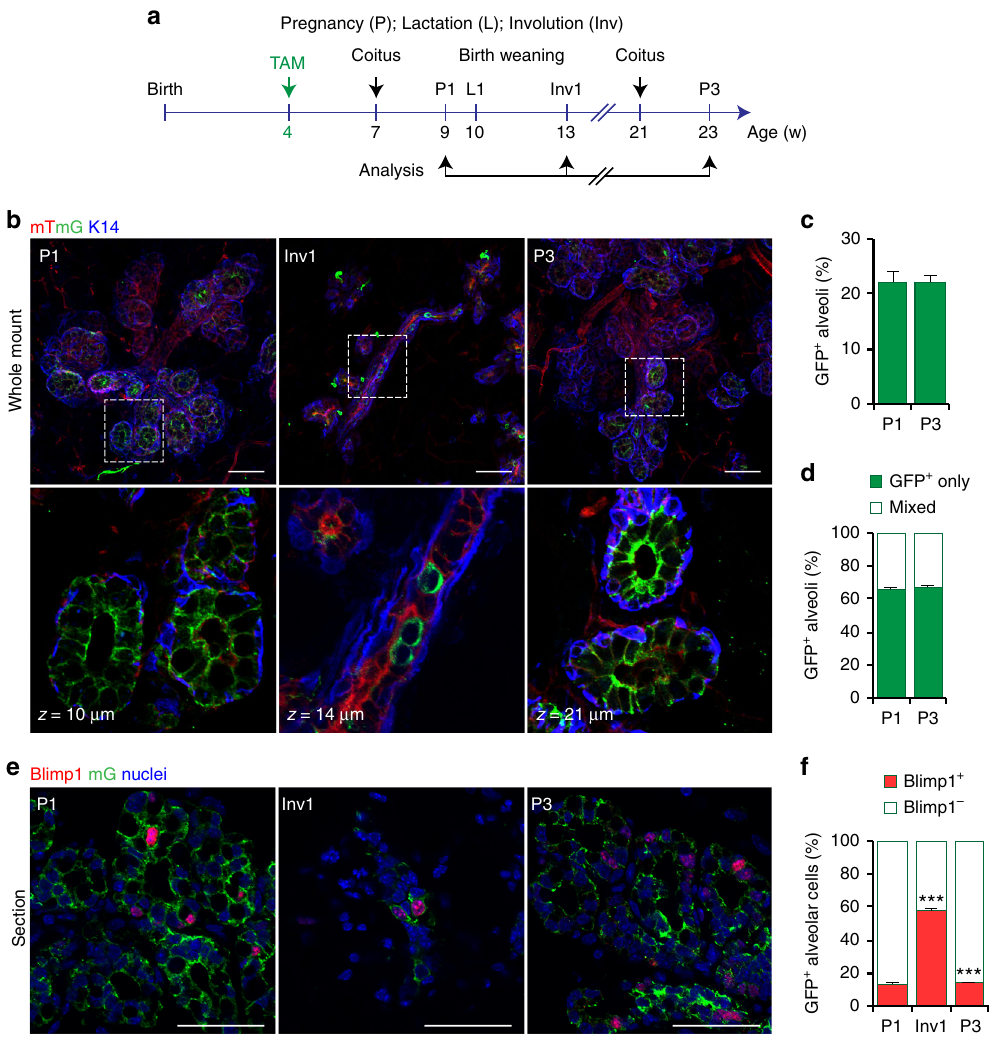
Fig. 4 Blimp1-derived cells represent long-lived luminal stem cells that contribute actively to consecutive pregnancies. a Lineage tracing strategy adopted in b – f . Four-week-old adult virgin Prdm1Cre ERT2/ + ; R26R mTmG/ + females were injected with TAM (4 mg/25 g body weight) and analysed at day 14.5 of the fi rst and third pregnancy (P1 and P3), and during day 14 of involution (Inv1). b 3D imaging of SeeDB-cleared P1, Inv1 and P3 mammary tissue. Glands are stained for GFP (green) and K14 (blue). mT is displayed in red. ( n = 3 mice for each time point). Scale bars, 50 μ m. c Percentages of GFP + alveoli in P1 and P3 mammary glands. Data are presented as mean ± s.e.m. (number of GFP + alveoli pooled from n = 3 mice per time point: n = 534 and n = 561, respectively). P > 0.05 ( t -test). d Percentages of GFP + alveoli at P1 and P3 containing either exclusively GFP + cells or mixed populations of GFP + and GFP − cells. Data are presented as mean ± s.e.m. (number of GFP + alveoli pooled from n = 3 mice per time point: n = 534 and n = 561, respectively). P > 0.05 ( t -test).